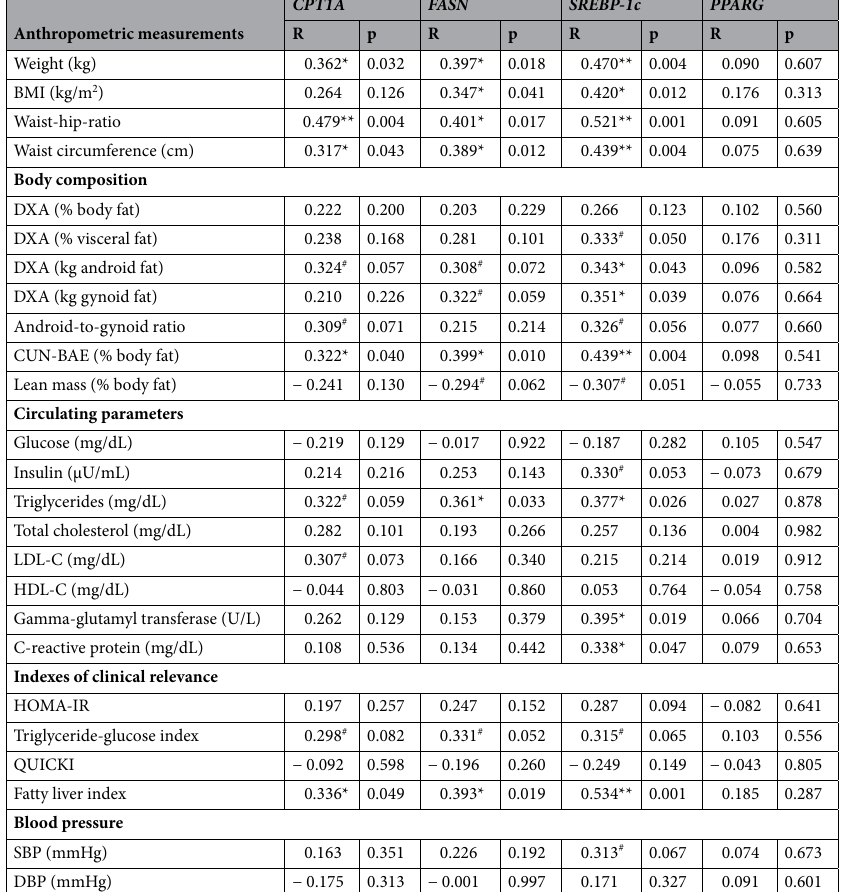
Table 5. Partial correlation of lipid metabolism genes with anthropometric, clinical and biochemical parameters from all the volunteers (NW and OW-OB), adjusted by sex and age. R = Pearson correlation coefficients and p values associated to each correlation. *p < 0.05, **p < 0.01 and # p < 0.1. NW (n = 20) and OW-OB (n = 27) data from the baseline point were